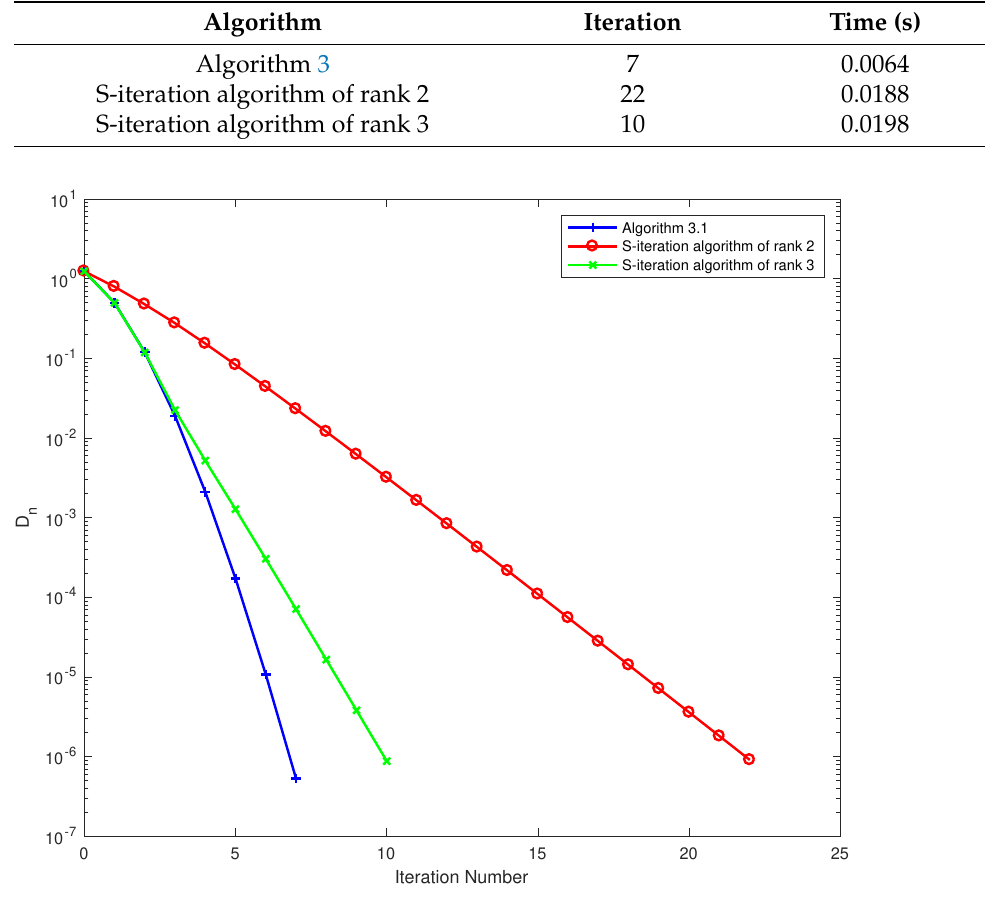
Figure 2. Numerical behavior of { D n } for Example